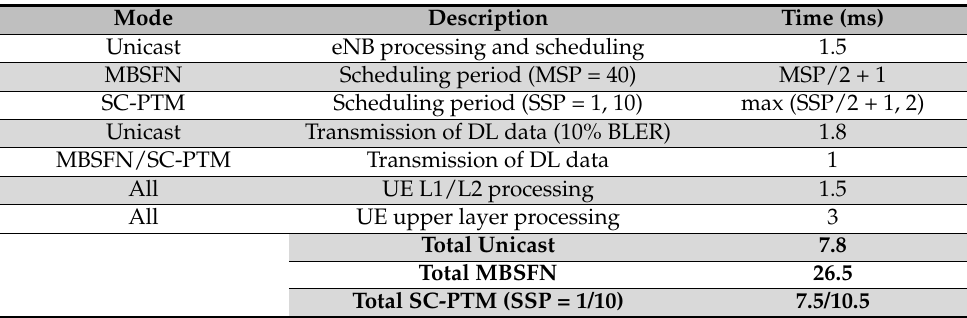
Table 6. Downlink delay in LTE-A